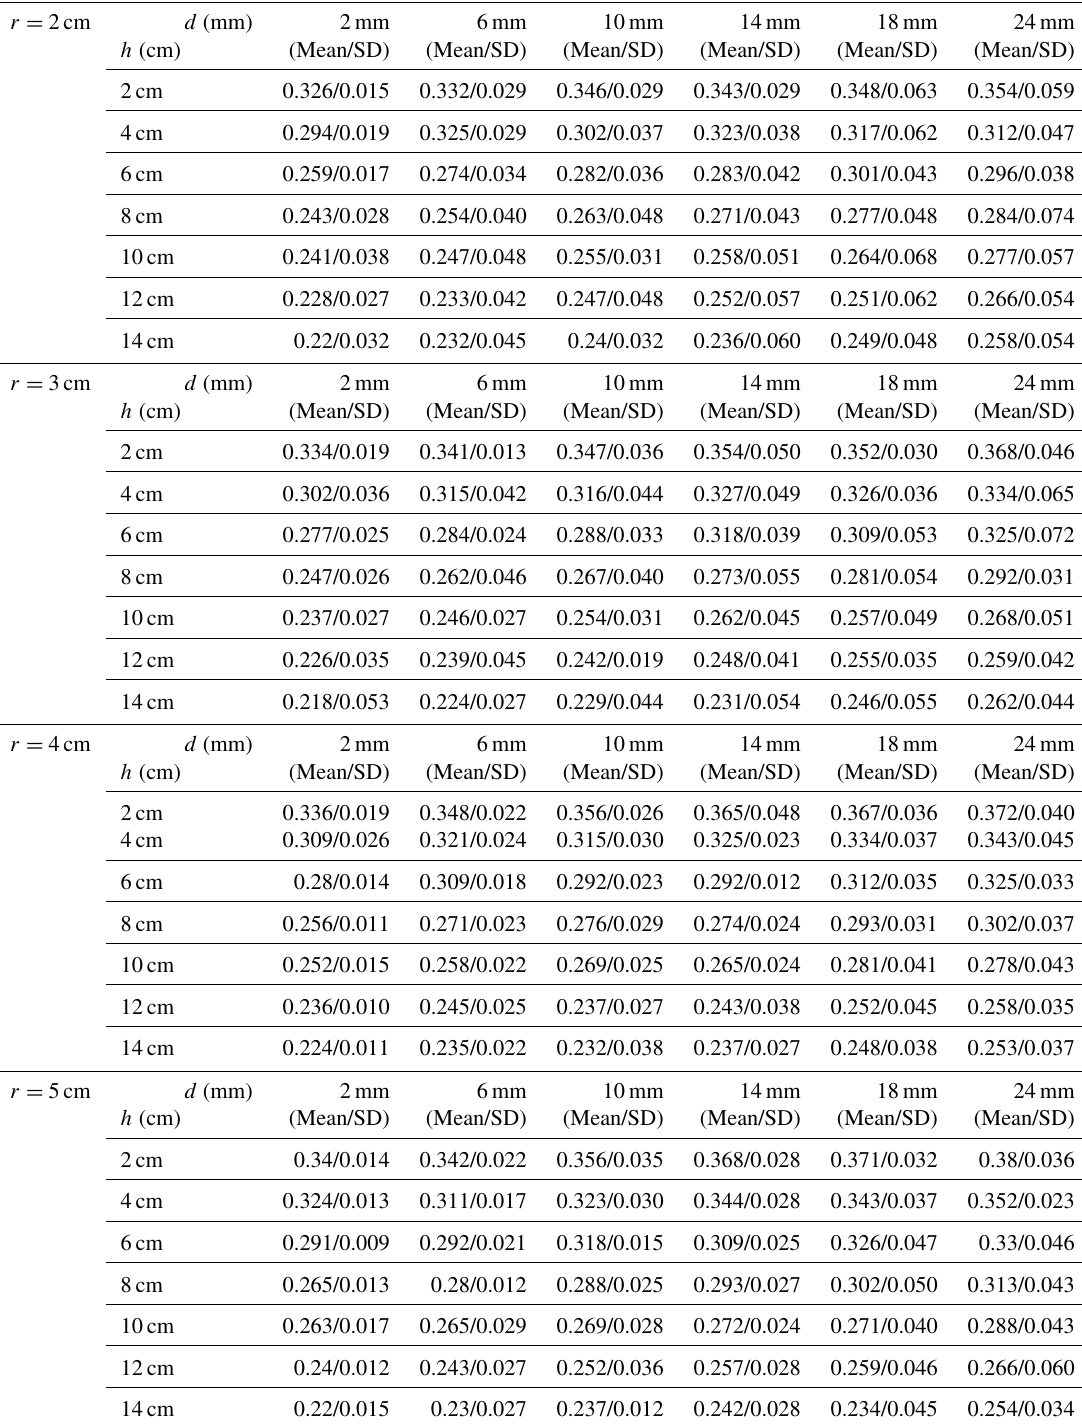
Table 2. Experimental results for the first group of tests (movement height H = 1 .